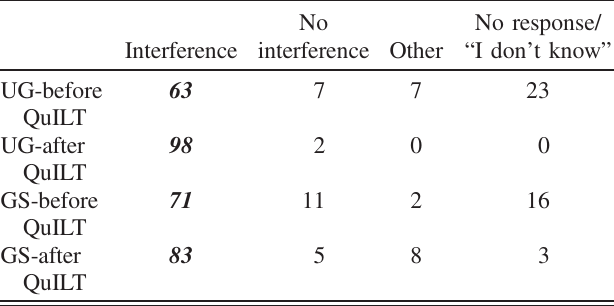
TABLE VII. Percentages of undergraduate (UG) and graduate students (GS) with different answers on Q1 (interference, no interference, other, and no response or “ I don ’ t know ” ). Bold italic indicates correct